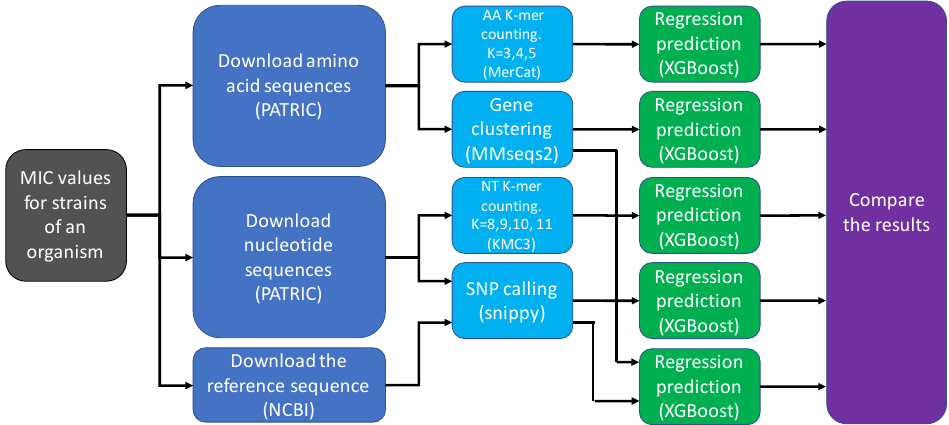
Figure 1. Overall pipeline for all feature extraction